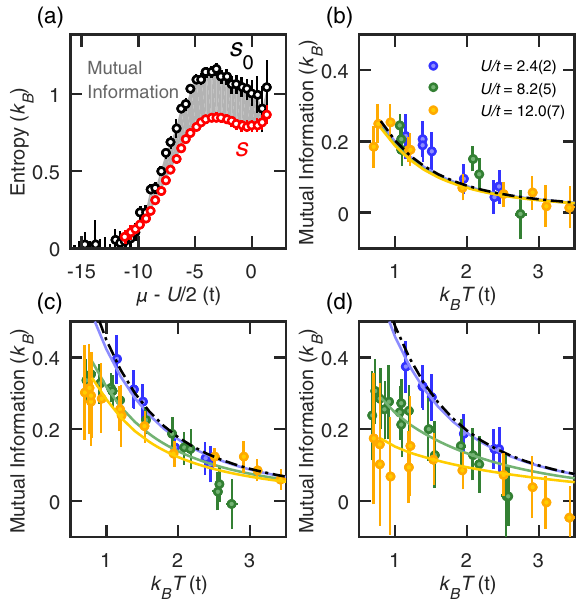
FIG. 3. Mutual information between a single lattice site and its surrounding environment for different fillings, interactions, and temperatures. (a) Data used to extract the mutual information, for the exemplary case of U=t ¼ 8 . 2 ð 5 Þ and k B T=t ¼ 1 . 09 ð 5 Þ . The mutual information is given by the difference between the single- site entropy s 0 and the thermodynamic entropy per site s . Mutual information for n ¼ 0 . 20 ð 2 Þ (b), n ¼ 0 . 67 ð 2 Þ (c), and n ¼ 1 . 00 ð 2 Þ (d). The lines are theory predictions extracted from NLCE data (solid lines) and for the noninteracting Fermi gas on a lattice (dash-dotted lines). The color code is the same for all plots. Error bars display the statistical measurement